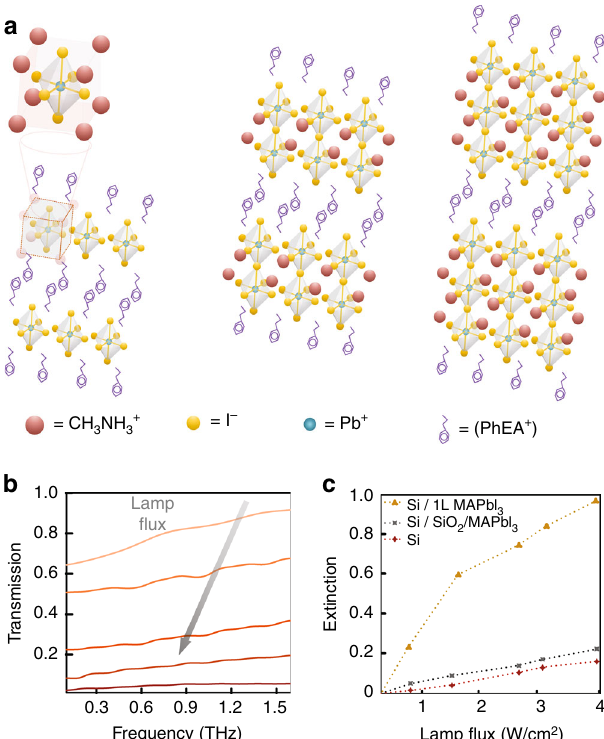
Fig. 1 2D PEPI perovskite molecular structure and THz absorption. a Molecular arrangement of layered structure of 2D organic – inorganic perovskites for n = 1, 2 and 3. In this structure, ‘ n ’ inorganic layers are separated by organic bilayers based on PhEA + . b THz transmission spectra through an n = 2 2D perovskite deposited onto a high resistivity Si wafer for various photoexcitation intensities, as measured by THz time-domain spectroscopy. The direction of the arrow corresponds to increasing lamp fl ux. c The THz transmission coef fi cient at 1 THz, measured as a function of the lamp intensity for four different substrates: fused silica/perovskite, bare high resistivity silicon, high resistivity/200 nm SiO 2 /perovskite, and high resistivity/200 nm SiO 2 /perovskite. Measurements were performed using optical radiation from a tungsten-halogen lamp, fi ltered to pass